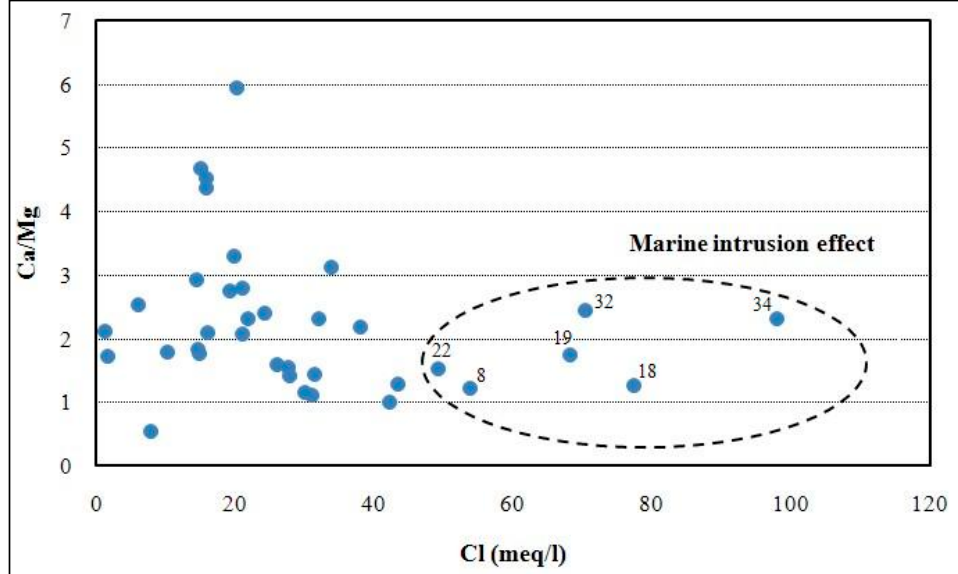
Figure 8. Ca/Mg vs. Cl plot in the study area.